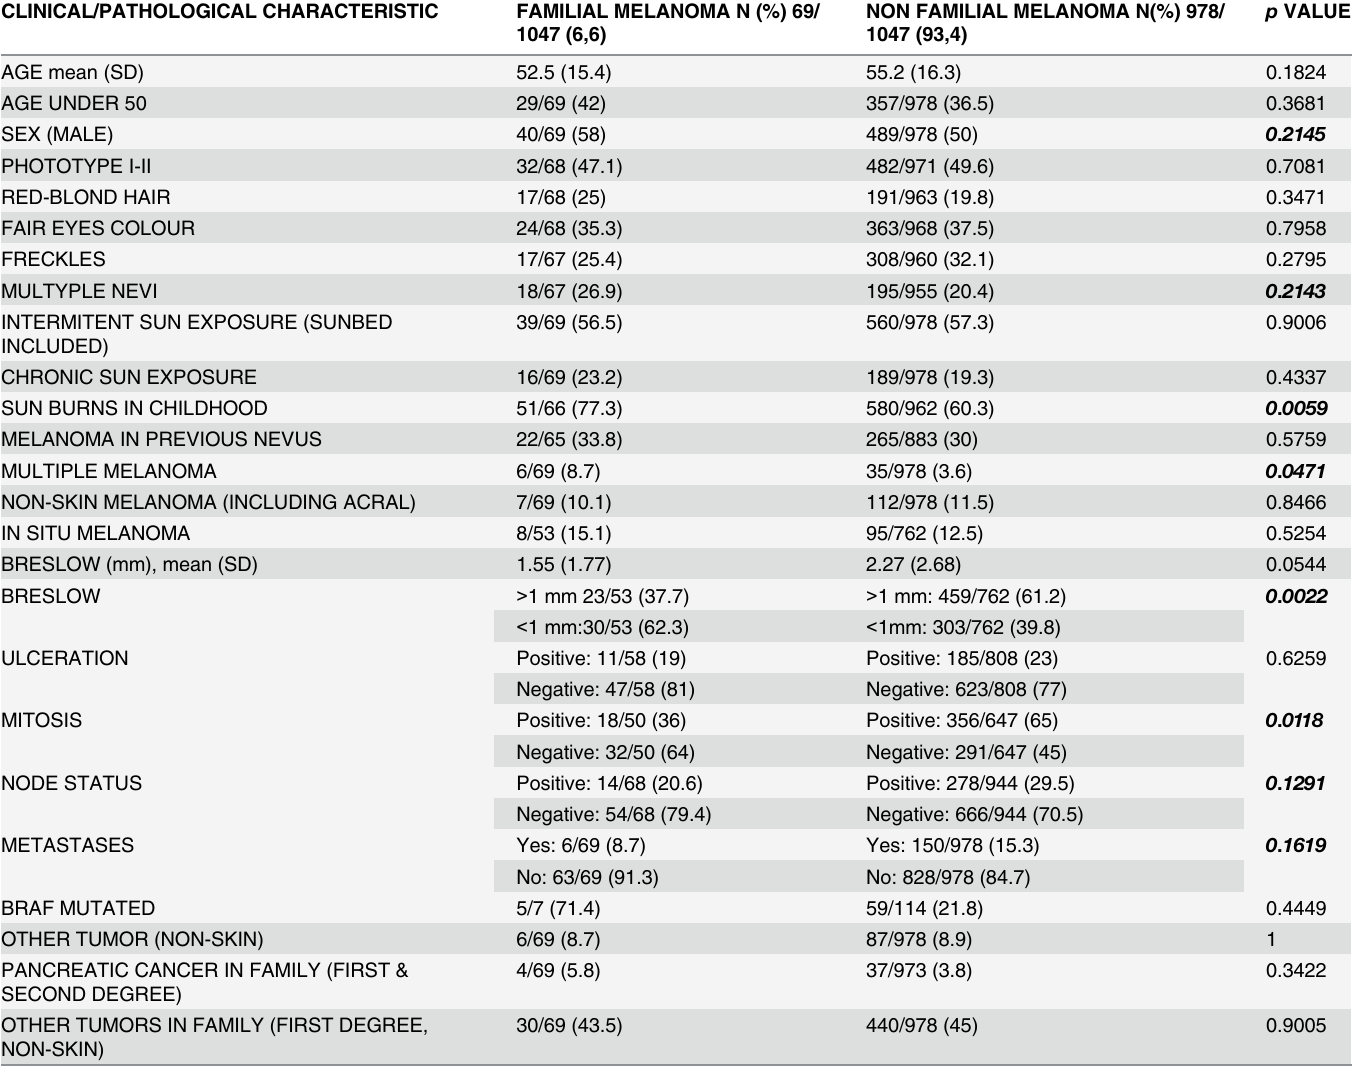
Table 2. Clinical and pathological characteristics of familial and non-familial melanoma